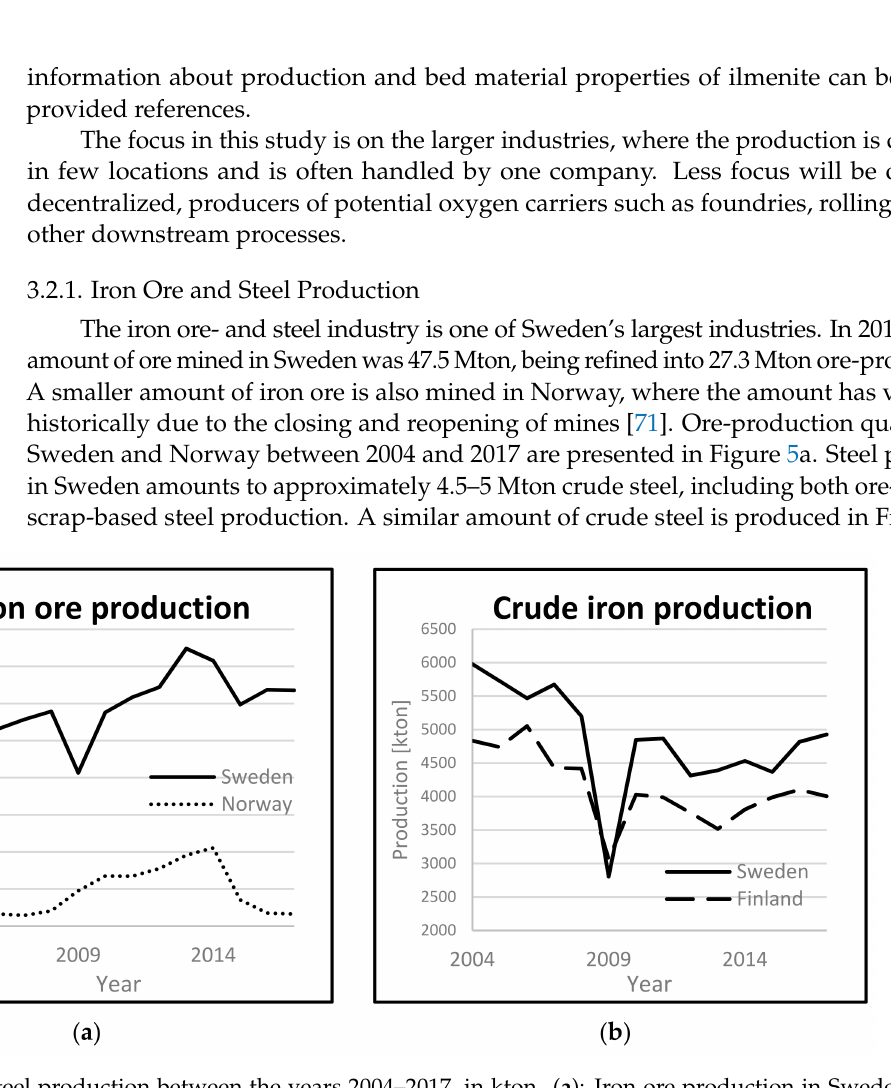
Figure 5. Iron ore and steel production between the years 2004–2017, in kton. ( a ): Iron ore production in Sweden and Norway. ( b ): Crude steel production in Sweden and Finland. Data from